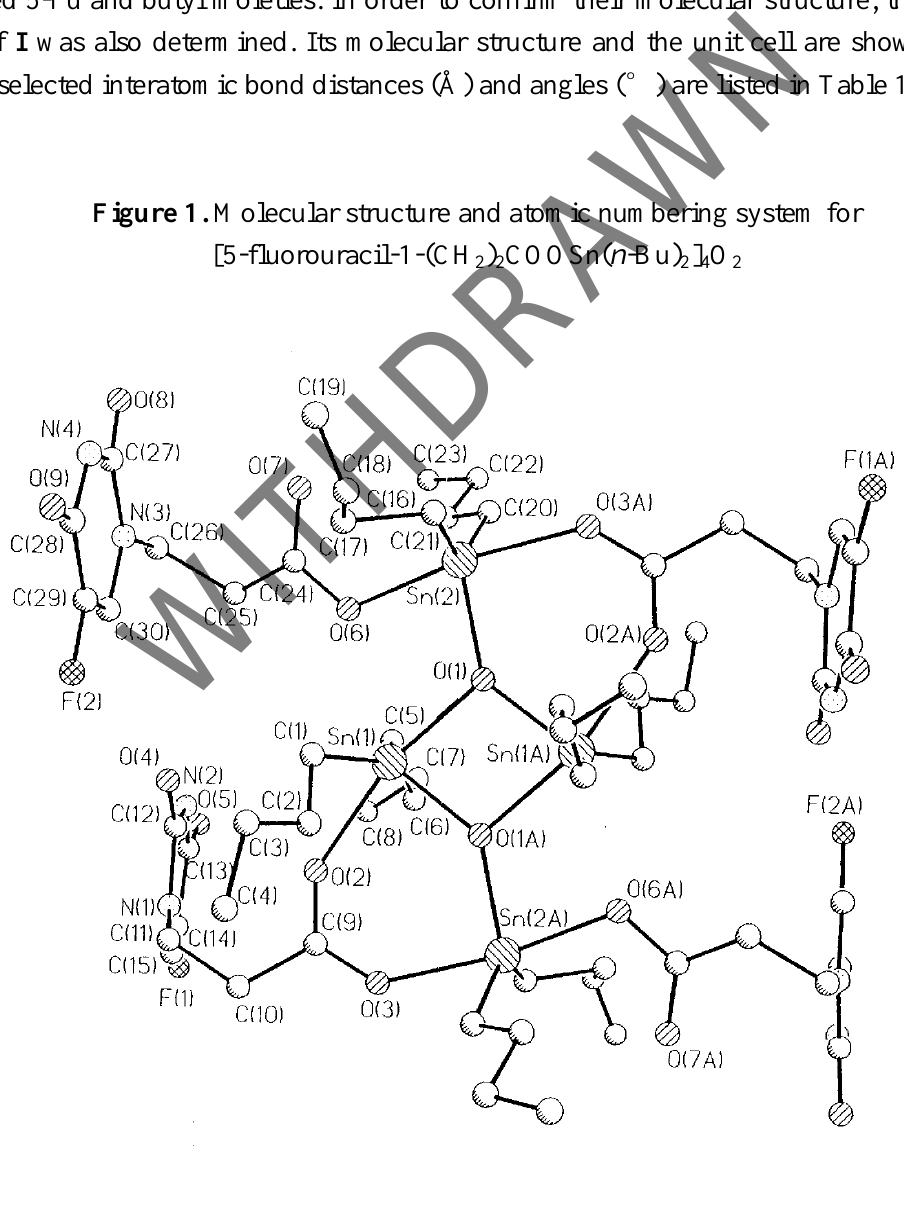
Figure 1. Molecular structure and atomic numbering system